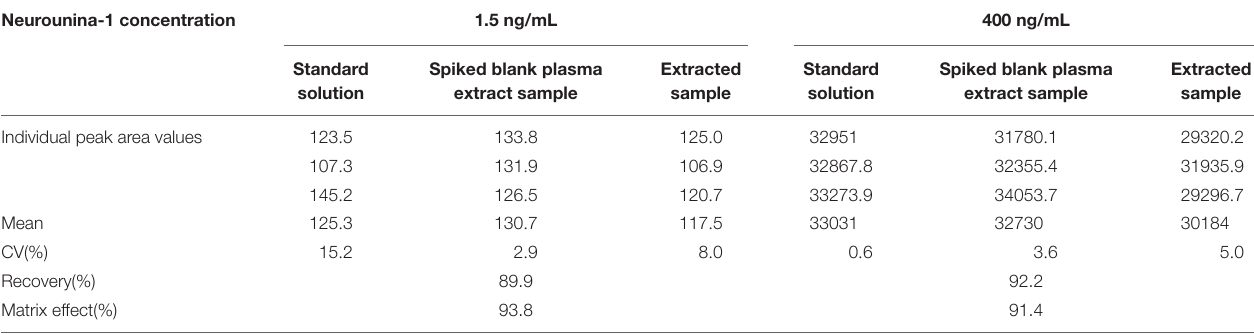
TABLE 2 | Recovery and matrix effect for neurounina-1 in eight different lots of beagle dog plasma (4 normal, 2 lipemic, and 2 hemolysate). Neurounina-1